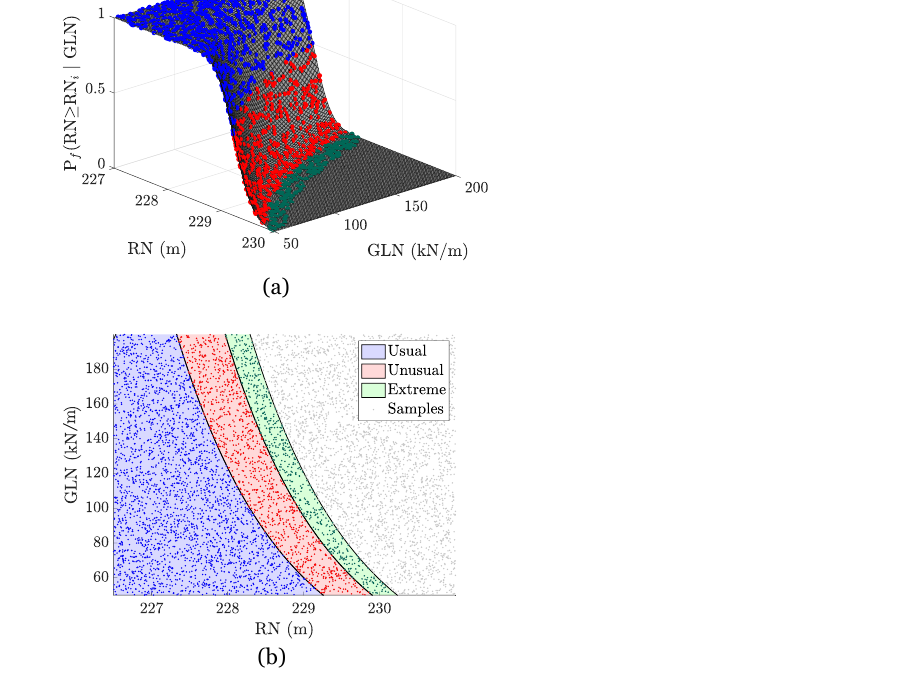
Figure 9. Samples per LC for D5: ( a ) cumulative density function, and ( b ) XY